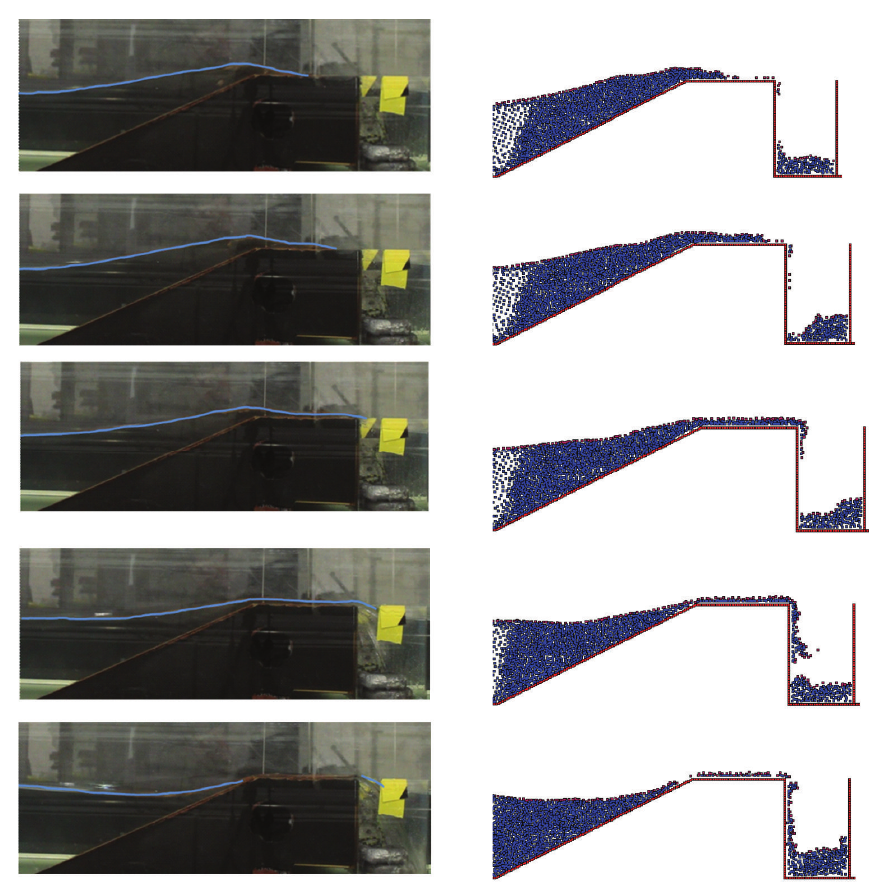
Figure 7: Visual comparison of one overtopping event obtained in the physical and numerical flume. The simulated case correspond to wave case 2, defined by H (cid:9) 0 . 07m and T (cid:9) 1 .